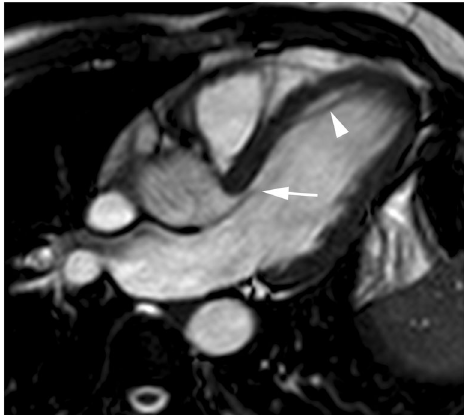
Fig. 2 20-year-old man, genotype positive, phenotype negative. End- diastolichorizontal long-axisSSFPcineMR imagedemonstrates an elon- gated anterior mitral valve leaflet (arrow) and normal length of posterior valve leaflet. A linear structure (arrowhead) that connects ventricular septum and left ventricular apex, corresponding to aberrant muscular band also can be seen